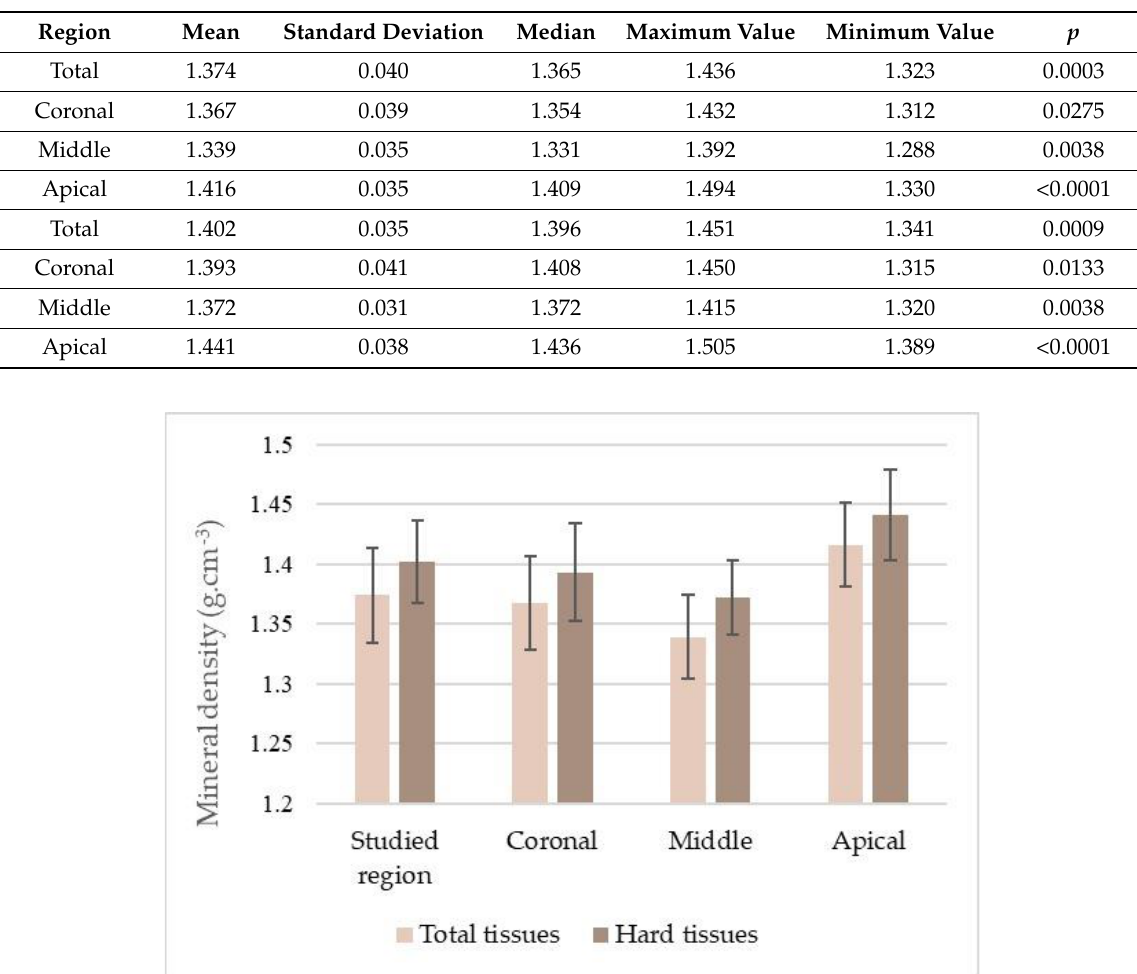
Table 1. Mineral density of total tissues and hard tissues in the studied region of the tooth and its thirds.